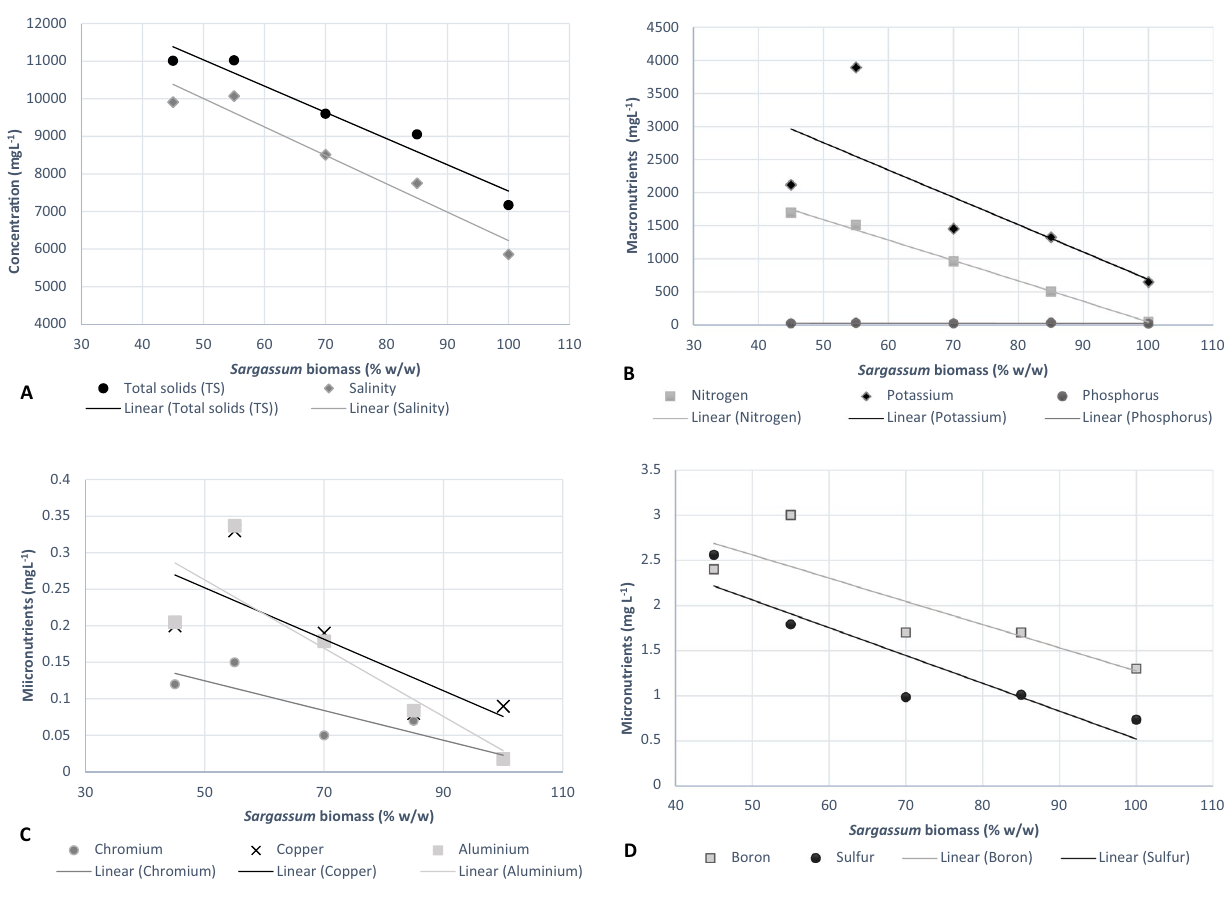
as function of the algal biomass percentage in the feed. The linear regression lines are shown in the plots